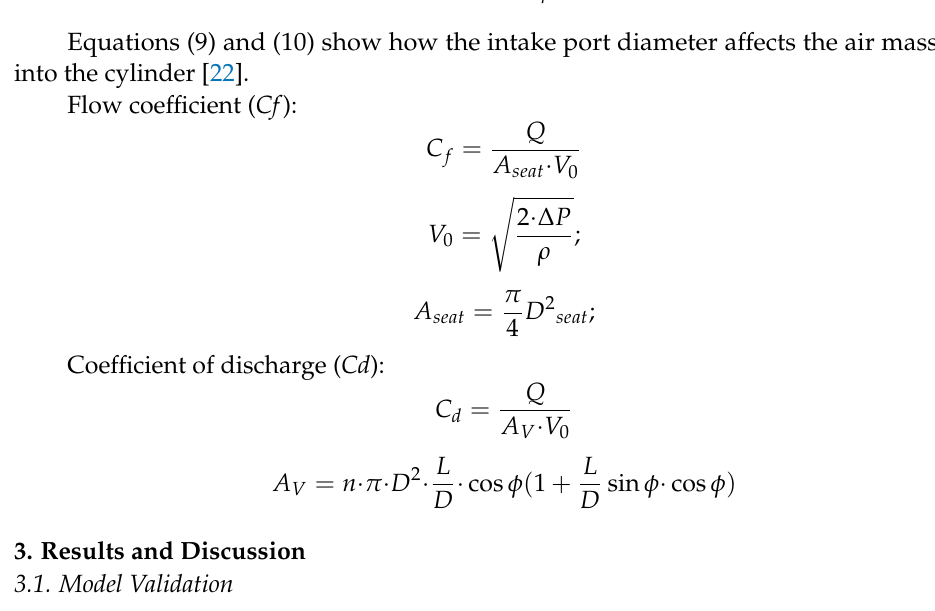
Figure 4. Volume efficiency versus IPD/B.